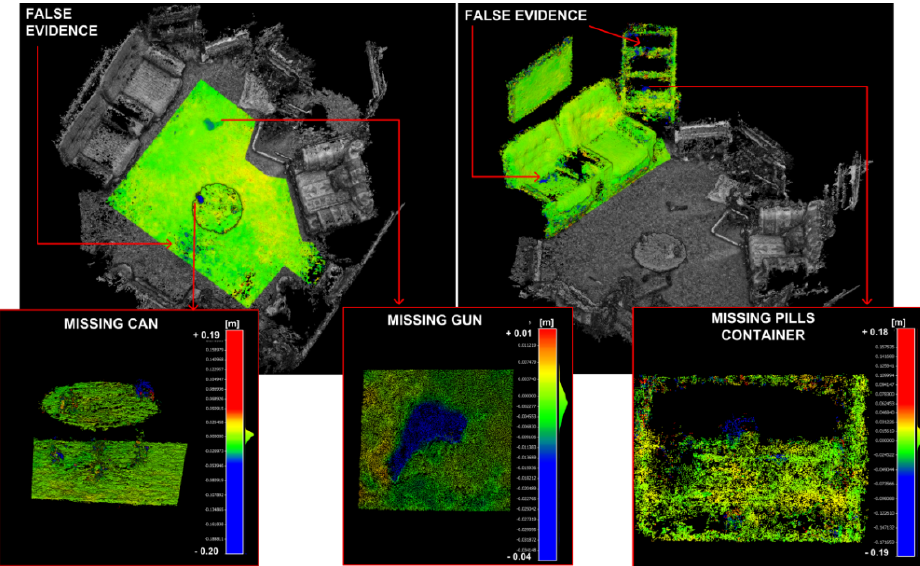
Figure 12. Colour-coded distance maps delivered by comparing pre- and post-contamination scenarios: results computed on large segmented areas (top) are then used to further analysed the suspected changes